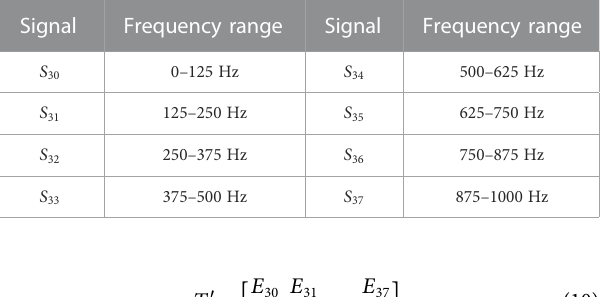
TABLE 1 Frequency range of the third layer reconstruction signal of transformer acoustic